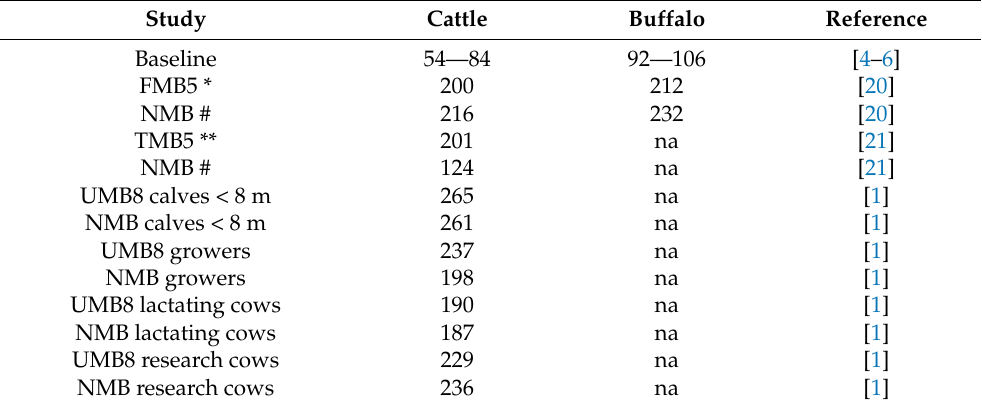
Table 1. Summary of mean ADGs (g/day) achieved in molasses blocks studies in Lao